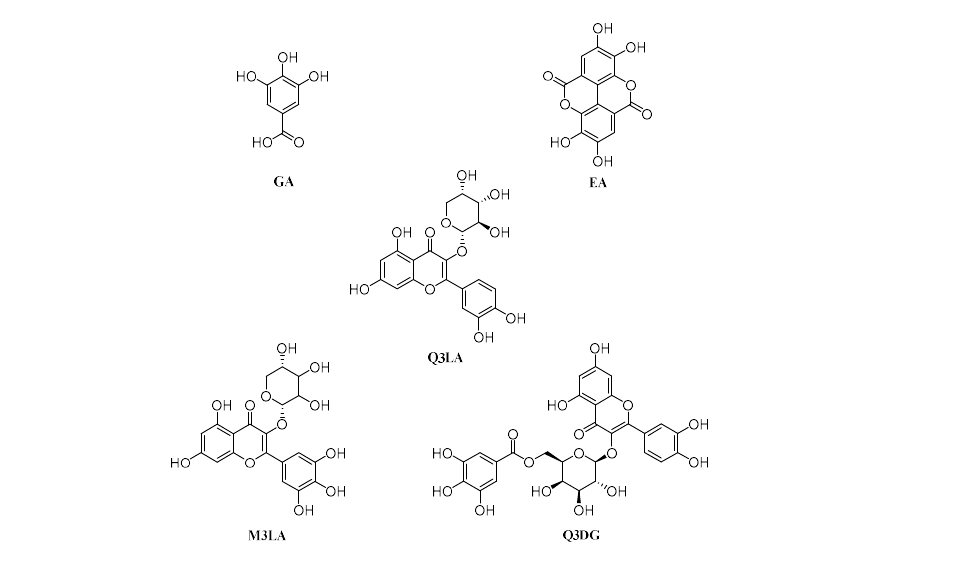
Figure 1. Chemical structures of the potential antidiabetic and antidepressant compounds screened from W. fruticosa leaves via computational analysis: GA (gallic acid), EA (ellagic acid), Q3LA (quercetin 3-O-α-L-arabinopyranoside), M3LA (myricetin 3-O-α-L-arabinopyranoside), and Q3DG (quercetin 3-O-(6"-galloyl)-β-D-galactopyranoside). Ligand Preparation